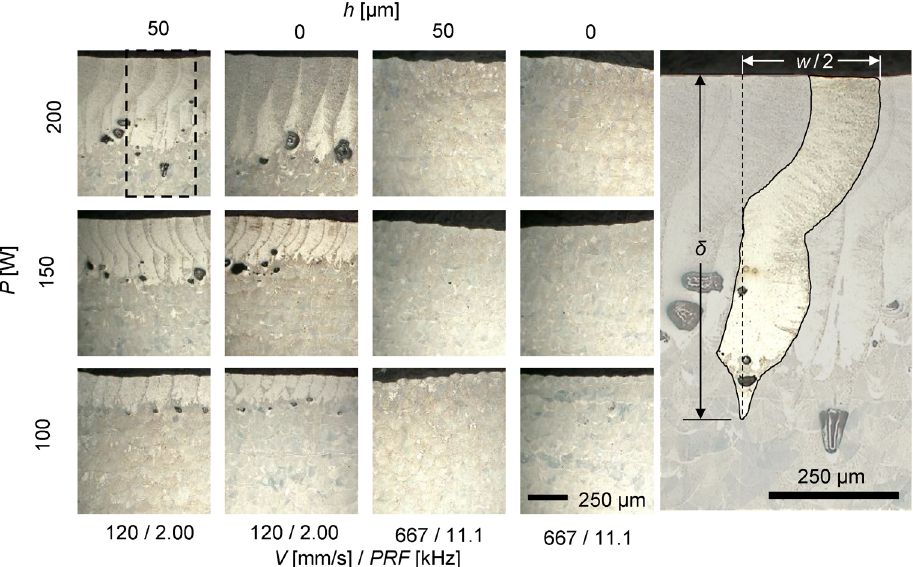
Figure 8. Sample micrographs for different laser powers, scan speeds, and PRFs with melt pool dimensions annotated in side picture that is annotated portion of melt pool indicated by dashed box.